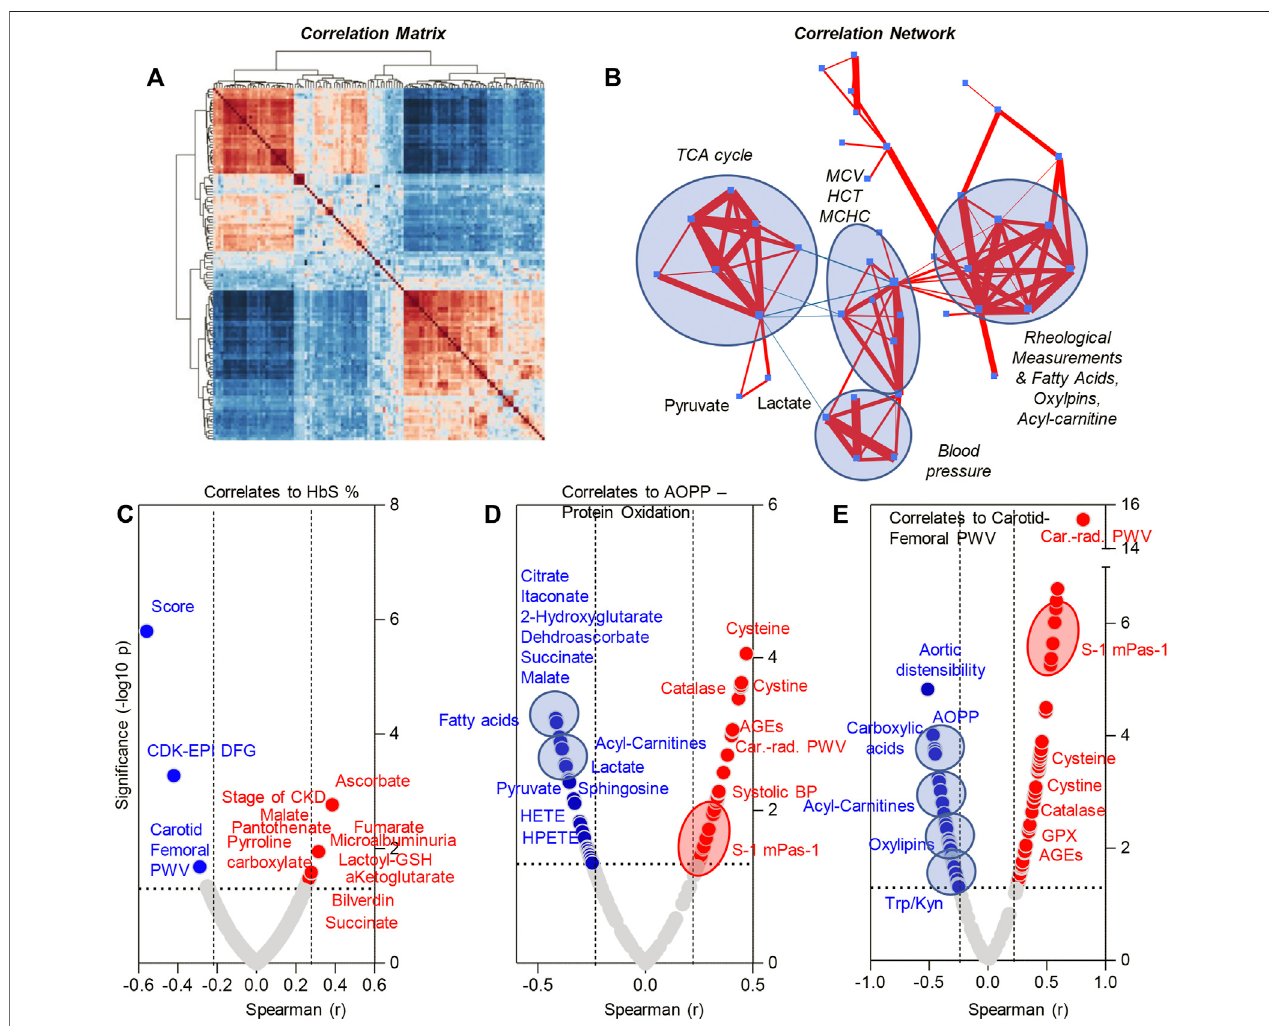
FIGURE3| Correlationmatrix (A) ,correlation network (B) andmetaboliccorrelatestoHbSlevels (C) ,advancedoxidationproteinproducts (D) andcarotidfemoral PWV (E) — Spearman correlation.